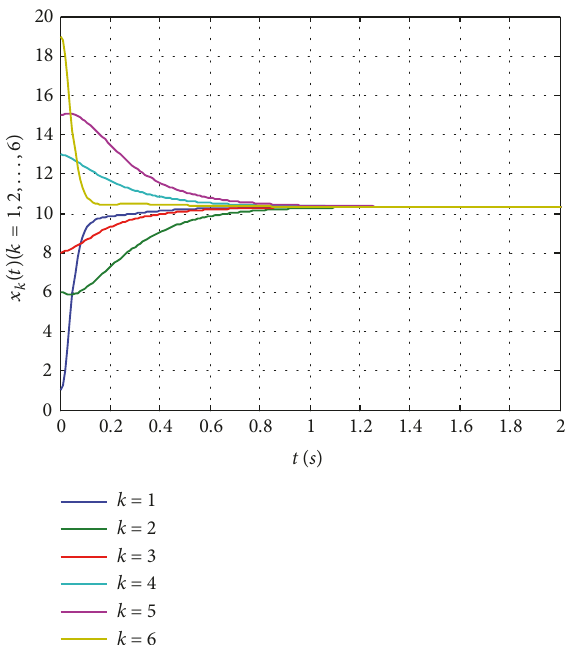
Figure 2: State trajectories under control protocol (2). Figure 3: State trajectories under the standard consensus protocol.